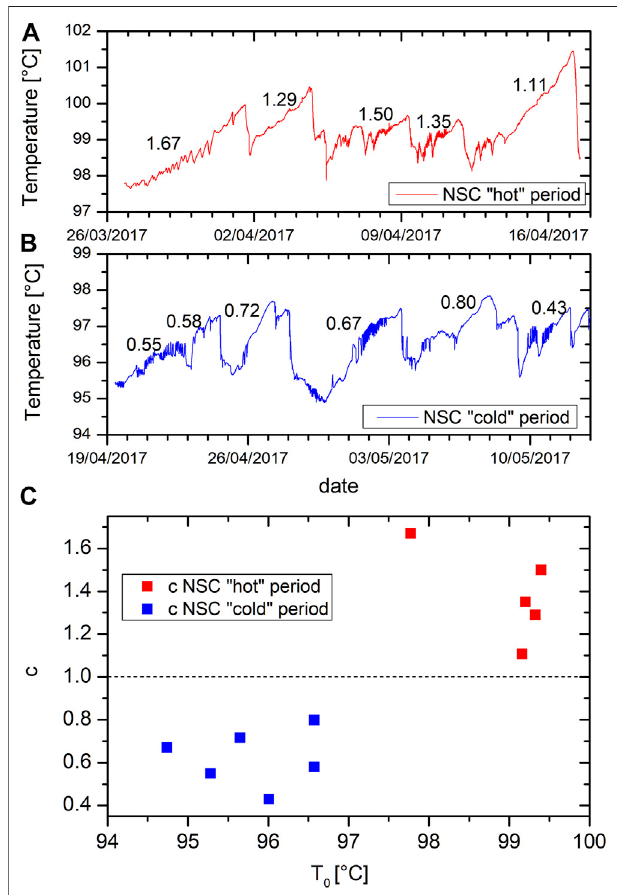
FIGURE 9 | Contrasted shape of hot ( (A) , red box in Figure 3 ) vs cold periods ( (B) , blue box in Figure 3 ) in the northern fumarole. Numbers are the exponentofapolynomial fi tquantifyingtheconcavity(c > 1)ortheconvexity(c < 1) (C) in fl uence of the fumarole temperature on the concavity.